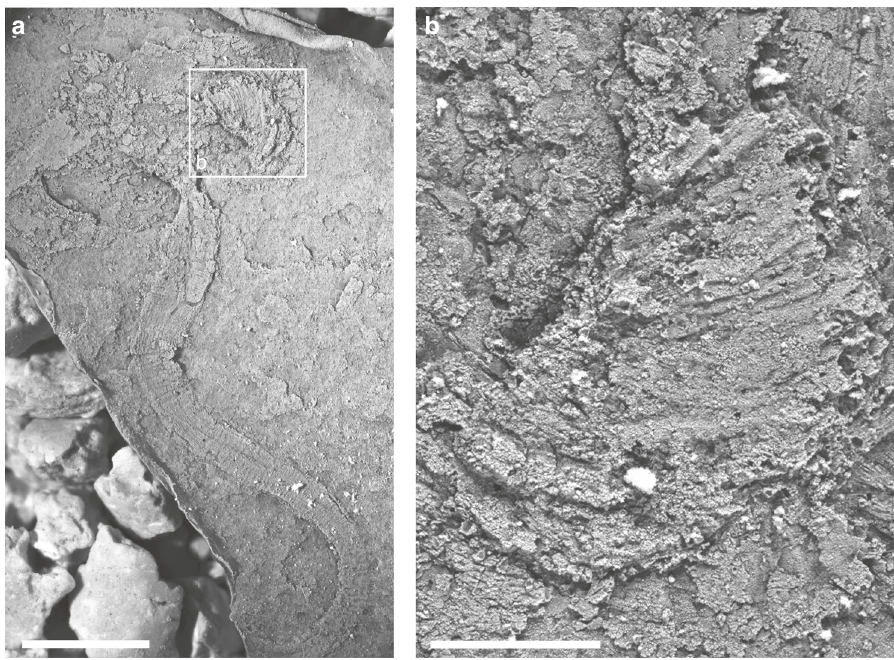
Fig. 1 Latex cast of Yanjiahella biscarpa from the lower Cambrian Yanjiahe Formation in China. Specimen ELI-HS7A. a Specimen with a plated theca and a muscular stalk with mean digestive tract visible, scale bar 4 mm. b Detail of plate, with no obvious stereom visible, scale bar 1